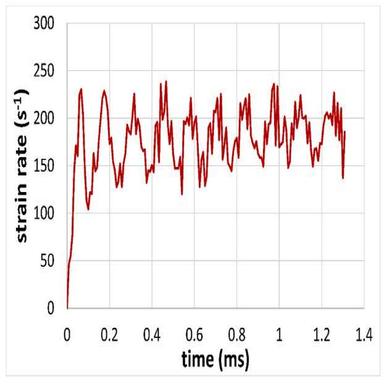
Evolution of average strain rate during the dynamic deformation (target strain rate: 200 s − 1 ).